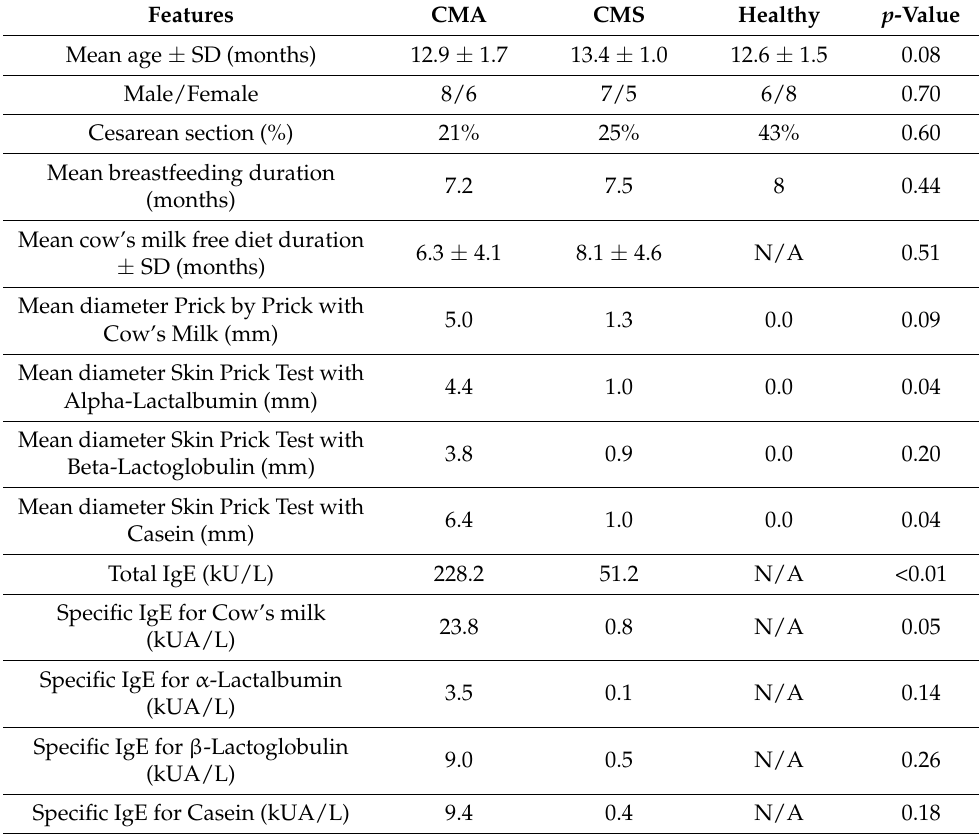
Table 1. Demographic and clinical characteristics of subjects. N/A, not